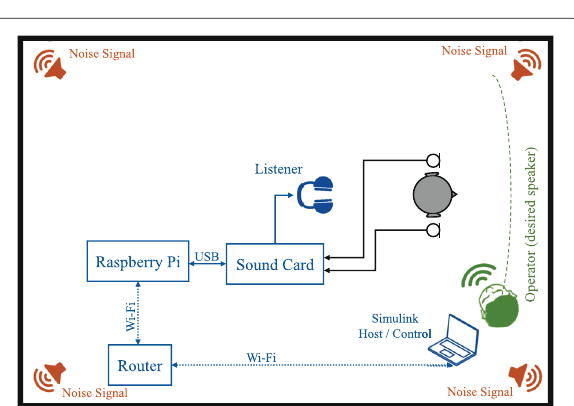
Fig. 10 Comparison of the proposed binaural cue-preserving MMSE filter and the bilateral filter in segmental SNR improvement Fig. 11 Schematic of the demonstration/evaluation